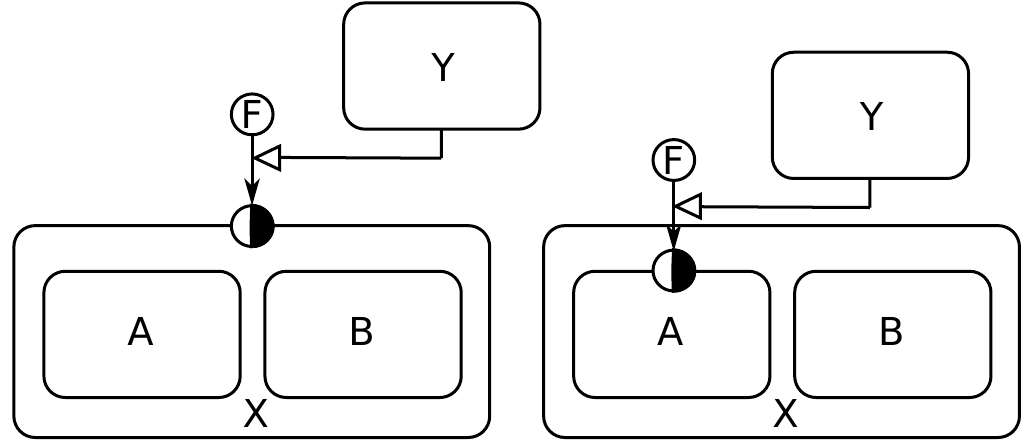
Figure 3.2: On the left, the entity Y causes the disappearance of the whole entity X, including its A and B components. On the right, only the entity A disappear, without effect on B and X as a